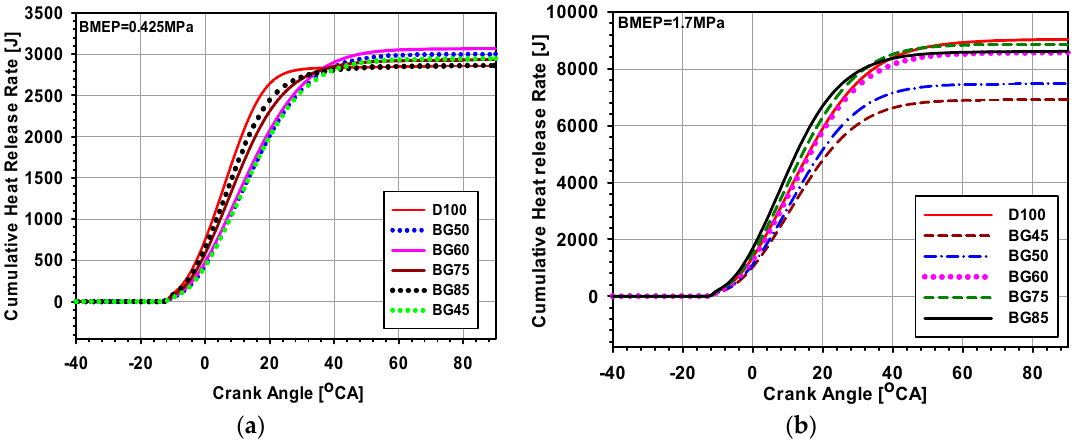
Figure 11. Variation of cumulative heat release with crank angle. ( a ) 0.425MPa; ( b ) 1.7MPa.